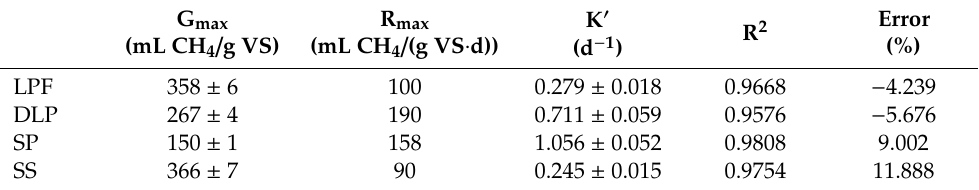
Table 2. Kinetics parameters obtained from the di ff erent biochemical methane potential tests. G